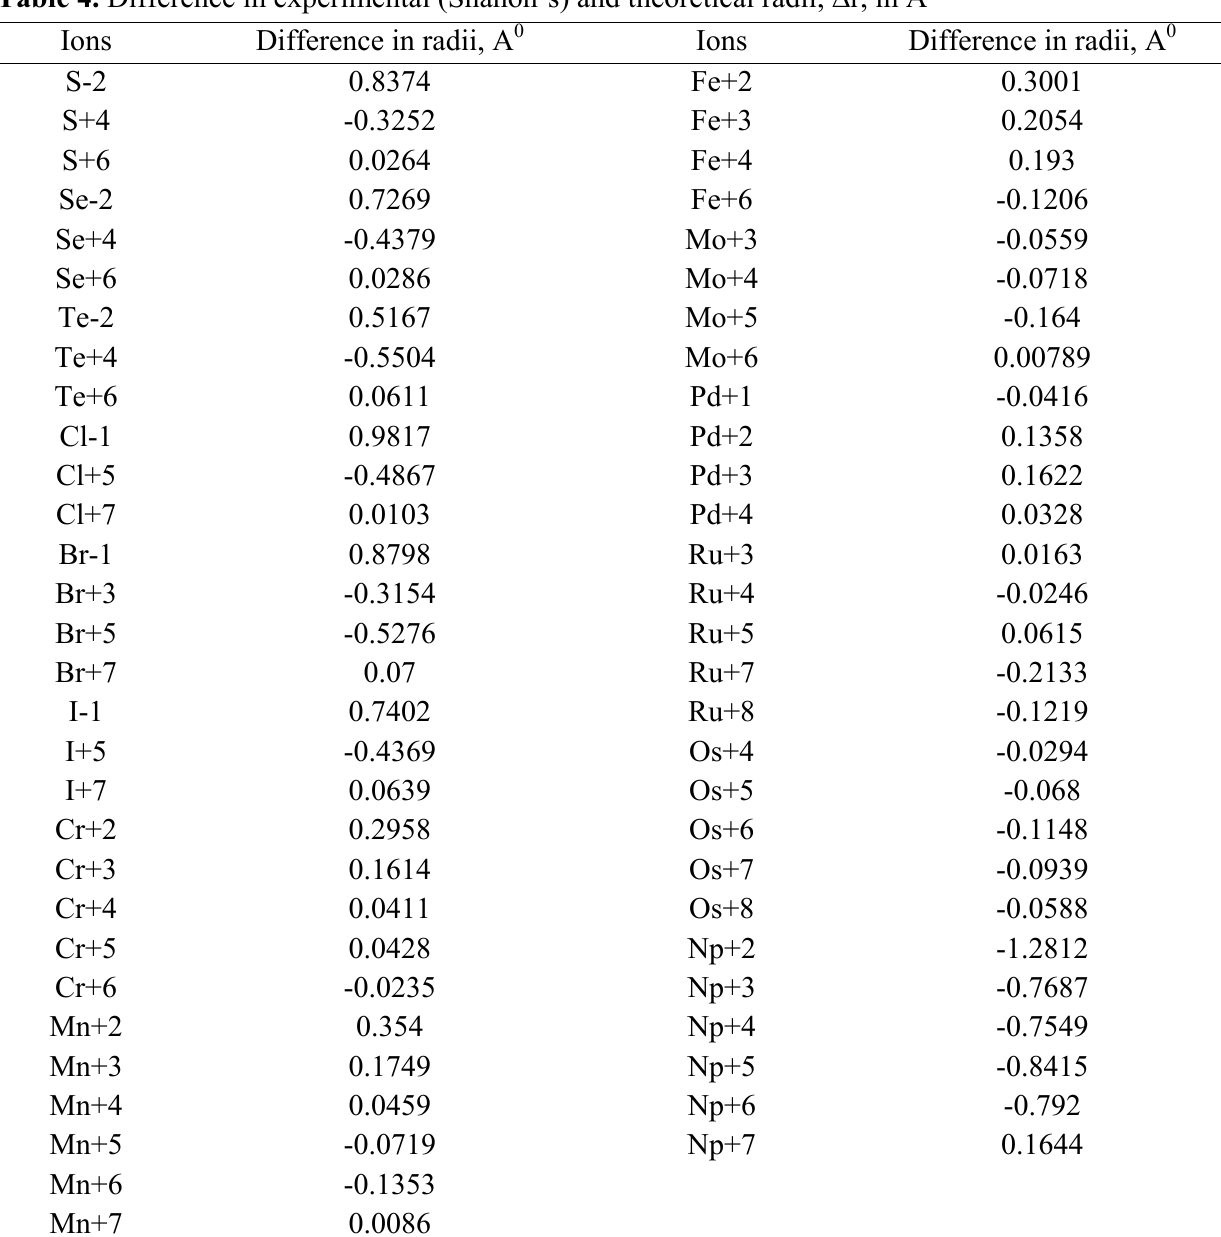
Table 4. Difference in experimental (Shanon’s) and theoretical radii, ∆ r, in A